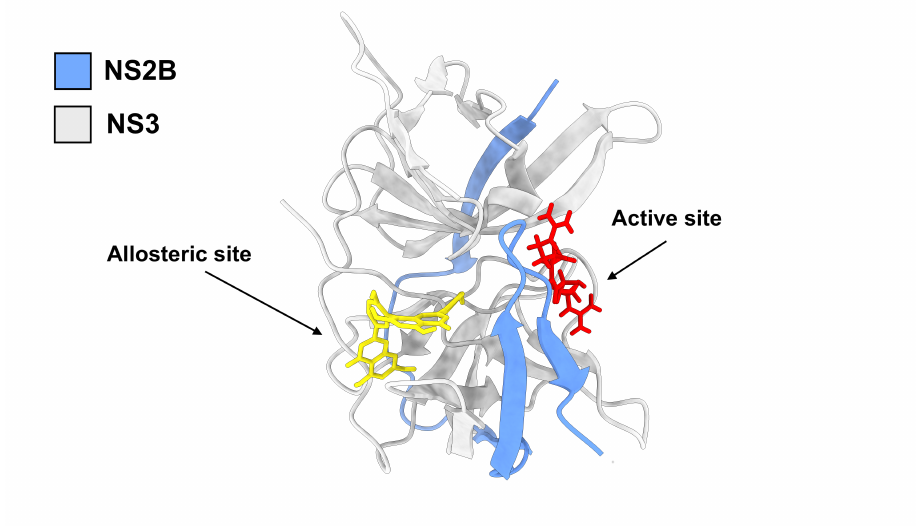
Figure 7. Representation of NS2B–NS3pro protein with emphasis on the allosteric and active sites.